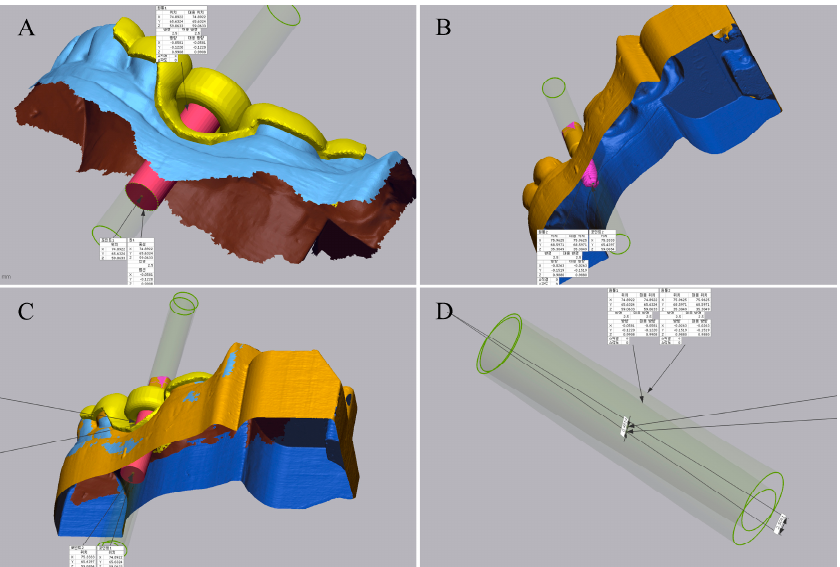
Figure 3. Digital evaluation method through 3D inspection software. ( A ) Planned implant position through an overlap between the data extracted from computer-guided implant software. ( B ) Placed implant position through scan body overlap. ( C ) Overlap between the data of the planned implants and the placed implants. ( D ) Deviation measurement through a virtual cylinder.